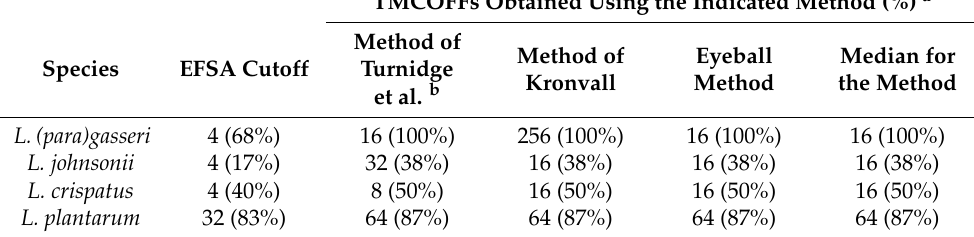
Table 2. Comparison of tentative microbiological cutoff values (TMCOFFs) for tetracycline calculated using two statistical methods and the eyeball